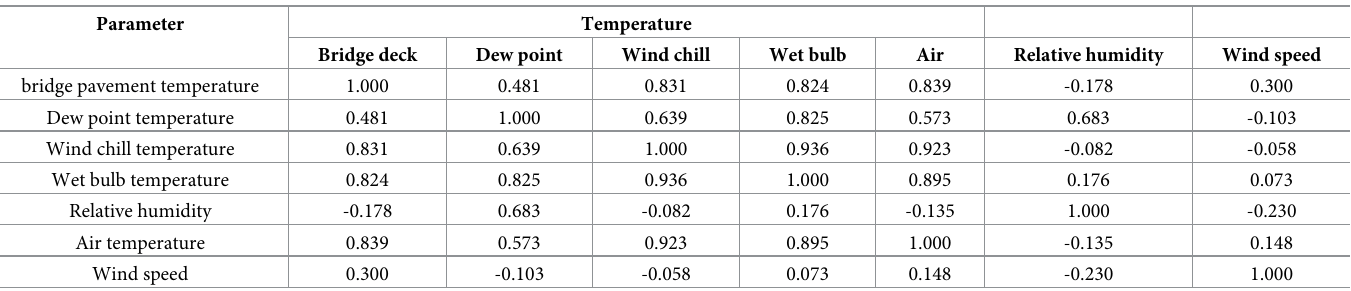
Table 2. Pearson partial correlation analysis results.